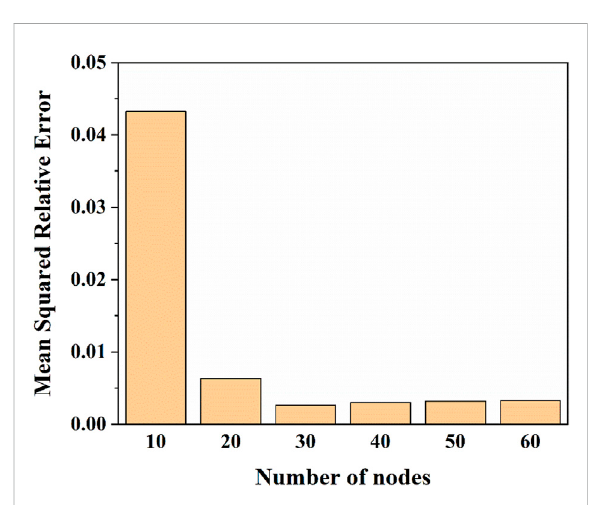
FIGURE 5 The performance comparison of the deep learning neural networks using different number of nodes in the hidden layers.